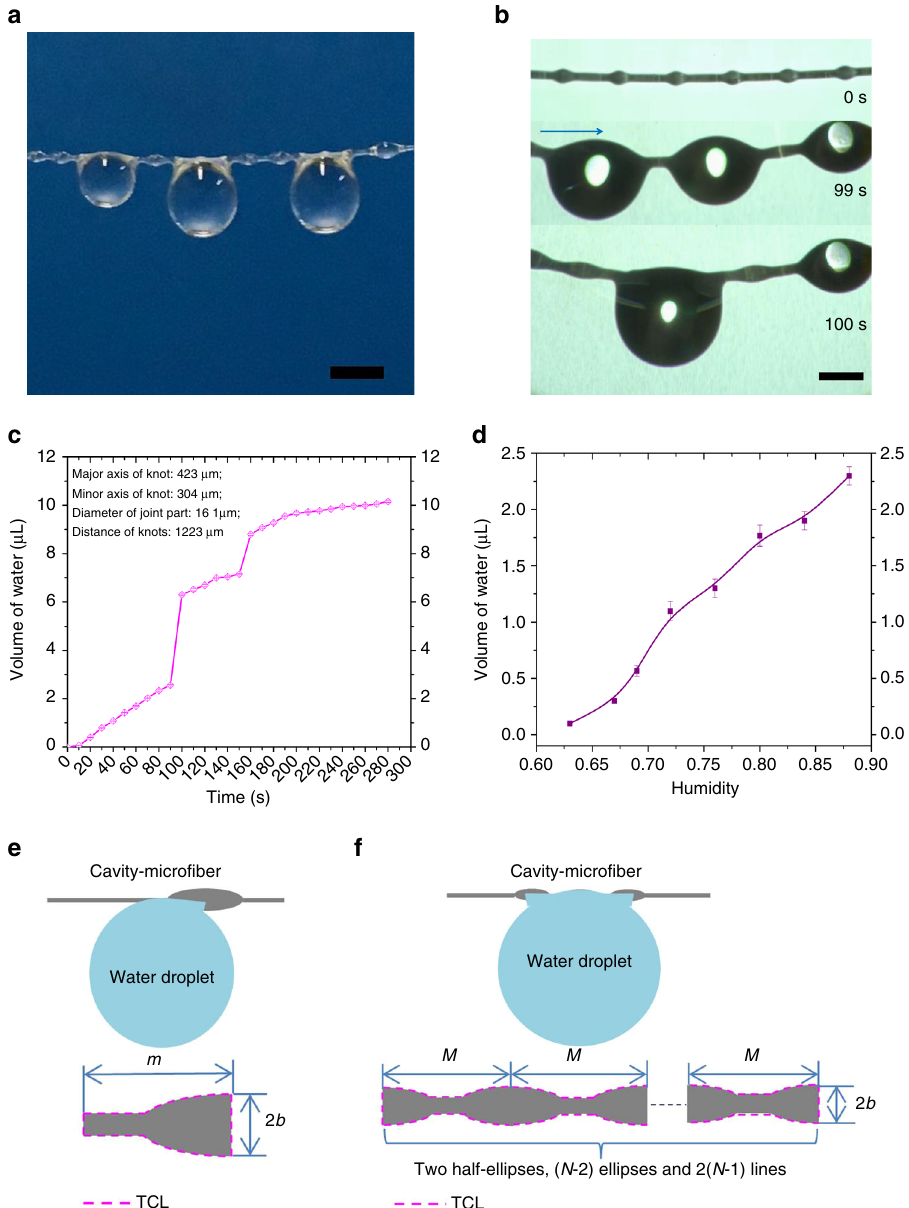
Fig. 3 Water collection of single dehydrated cavity-micro fi ber. a The optical image of water droplets collected on a single dehydrated cavity-micro fi ber (fog fl ow: 0.408 mL min − 1 ). b The water droplet collected on random knots move towards a domain knot (fog fl ow: 0.408 mLmin − 1 ). c The relationship between the time and the volume of water droplet collected (fog fl ow: 0.408 mL min − 1 ). d The relationship between the humidity and the volume of water collected under airtight environment with no air convection. e The schematic diagram of TCL for water droplet detaching from one spindle knot of cavity- micro fi ber. f The schematic diagram of TCL for water droplet detaching from N spindle knots of cavity-micro fi ber. All error bars in ( c ) and ( d ) indicate the standard deviations over fi ve independent measurements. Scale bars, 2 mm in ( a ) and 1 mm in ( b